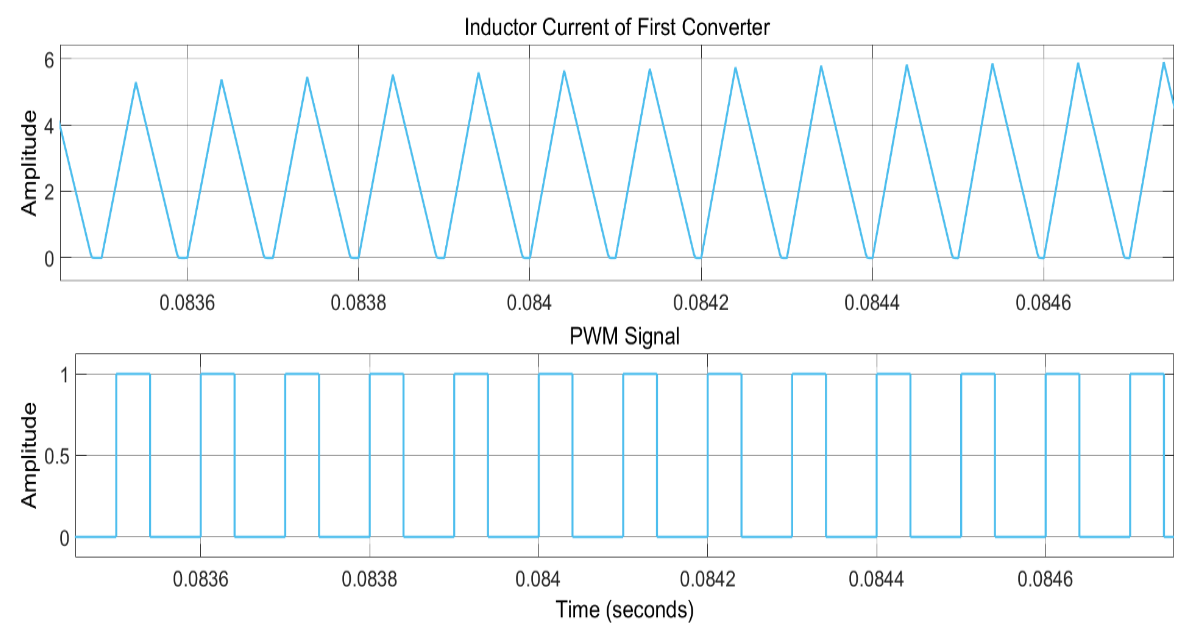
Figure 16. Inductor current w.r.t. gate pulses in converter CCM mode of operation.